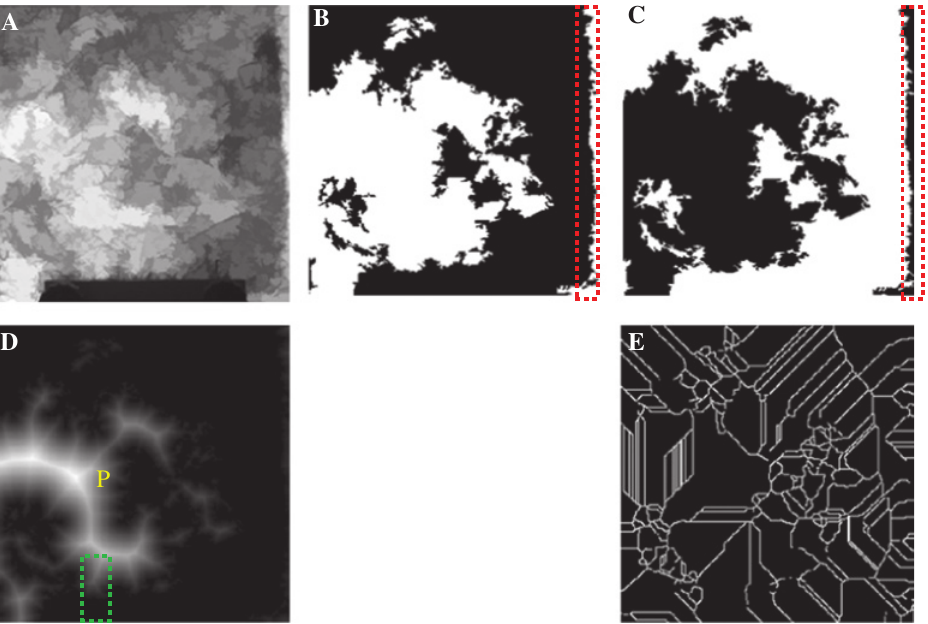
Figure 11 (A) Preprocessed image by morphological operator, (B) binary processing image, (C) complement of binary image, (D) distance transform, (E) image of watershed ridge